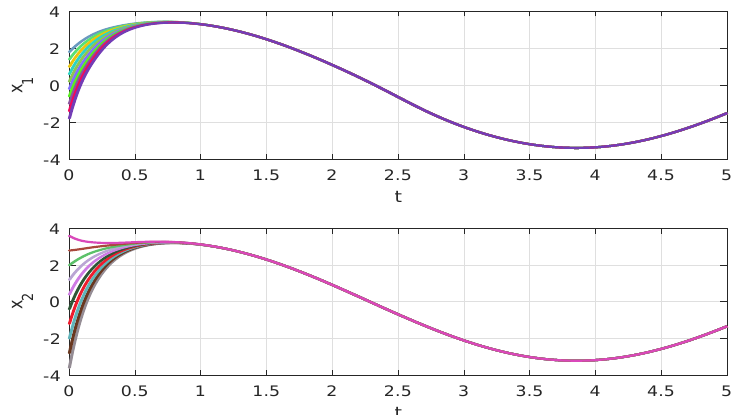
Figure 1. An illustration on the time responses with respect to the real parts pertaining to the model in (20), in which ˜ u ( t ) = sin ( 0.02 t ) e − 0.005 t in Example 1.